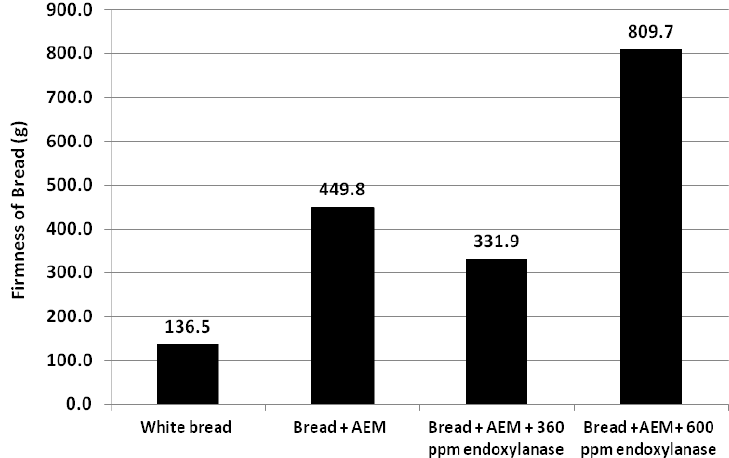
Figure 2. Bread crumb firmness of white bread, bread + AEM, bread + AEM with